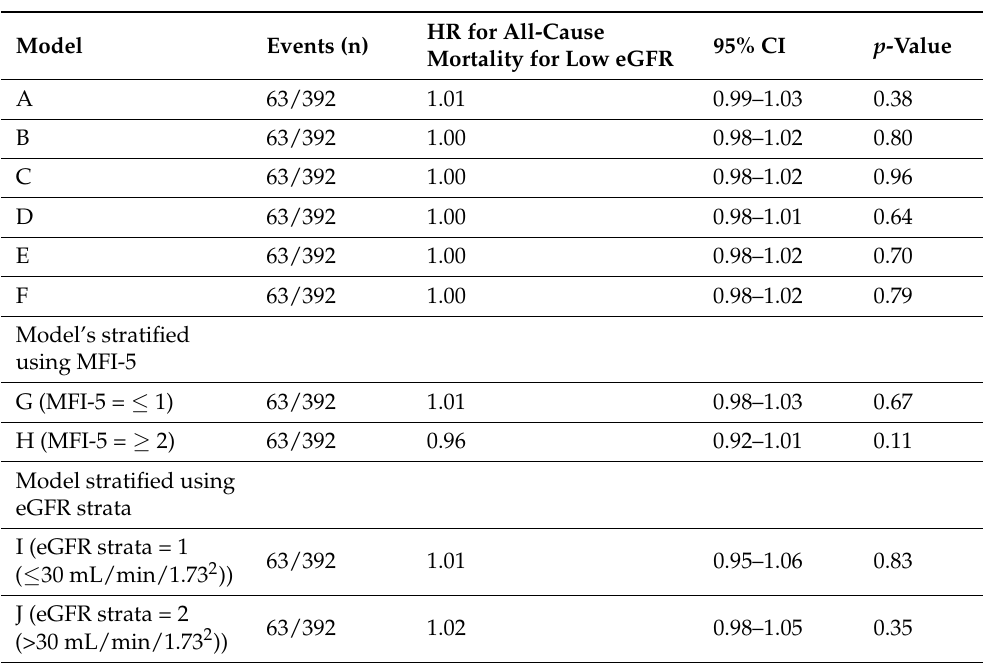
Table 2. Cox regression analysis results showing the association of eGFR as a predictor and all-cause mortality as outcome in oldest old adjusted for confounders and stratified by MFI-5 and eGFR using full model (Model